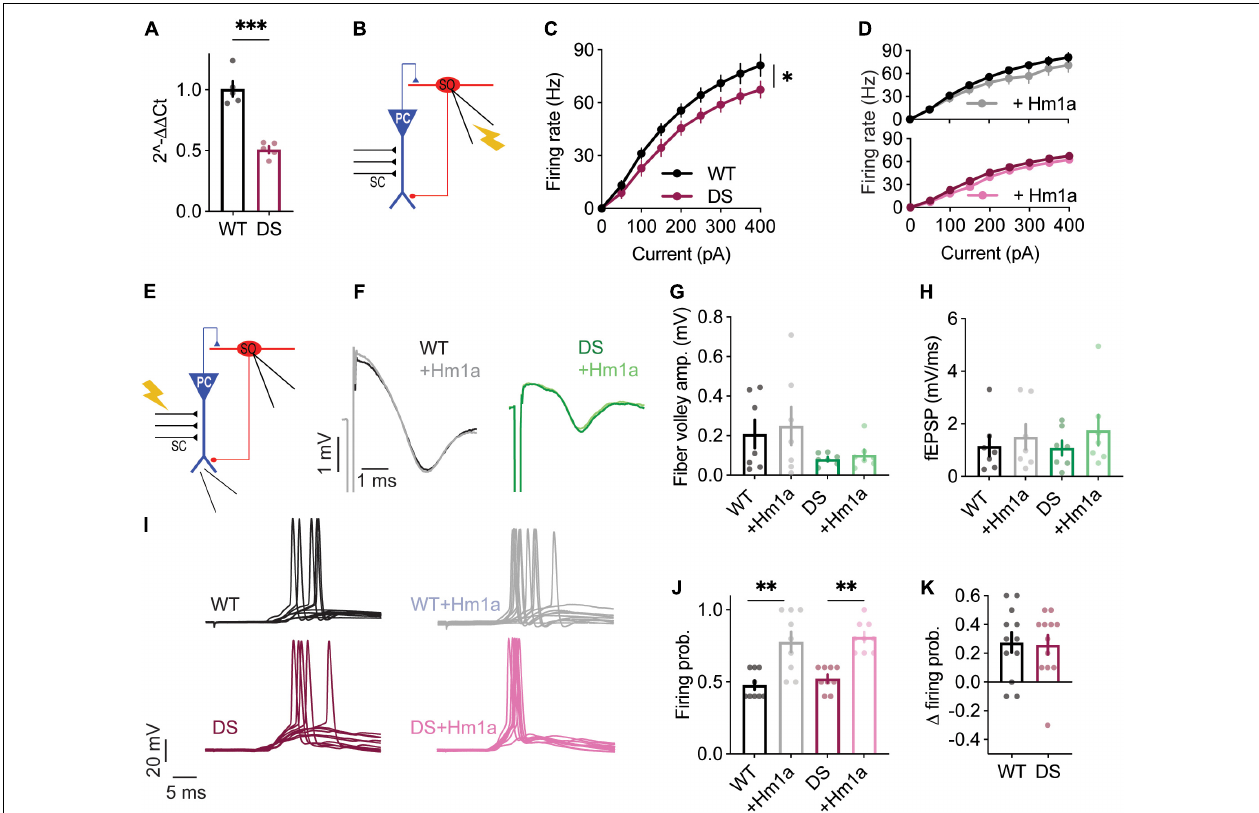
FIGURE 5 | Hm1a increased the firing of DS Scn1a R613X / WT SO interneurons following SC stimulation. (A) Quantitative real-time PCR analysis of hippocampal Scn1a mRNA expression, n = 5 in each genotype. Statistical analysis utilized unpaired t -test. (B) Illustration of the experimental setup used for (C,D) . (C) Firing frequency in response to depolarizing current injection at the indicated intensities in WT and DS. (D) The effect of Hm1a on firing frequencies, in response to current injection through the whole-cell patch electrode in WT and DS mice. Statistical analysis in panels (C,D) utilized Mixed Model Repeated Measures ANOVA. (E) Illustration of the experimental setup used for (F–K) . (F) Representative traces of WT (black or gray) and DS (green or pale green) field potentials before and after Hm1a application. (G,H) Average fiber volley amplitudes (G) and fEPSP (H) before and after Hm1a application. Statistical analysis utilized Two Way